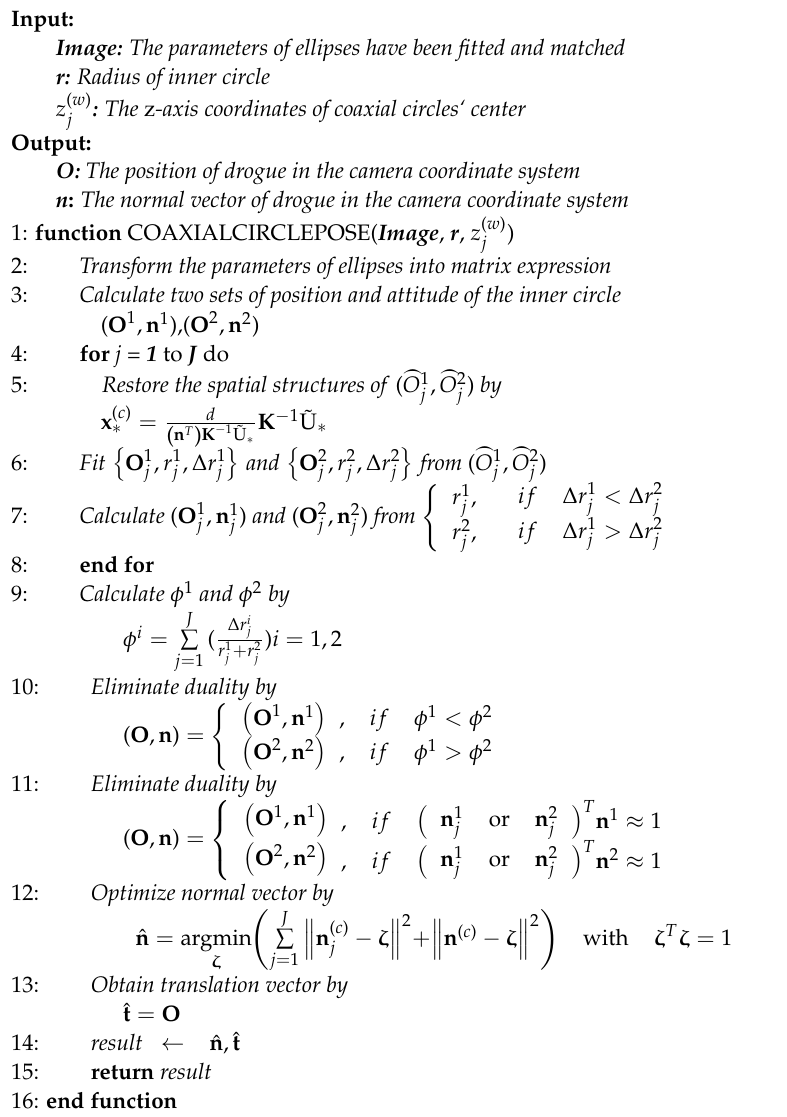
Algorithm 1: Position and Attitude Estimation Algorithm Based on the Coaxial